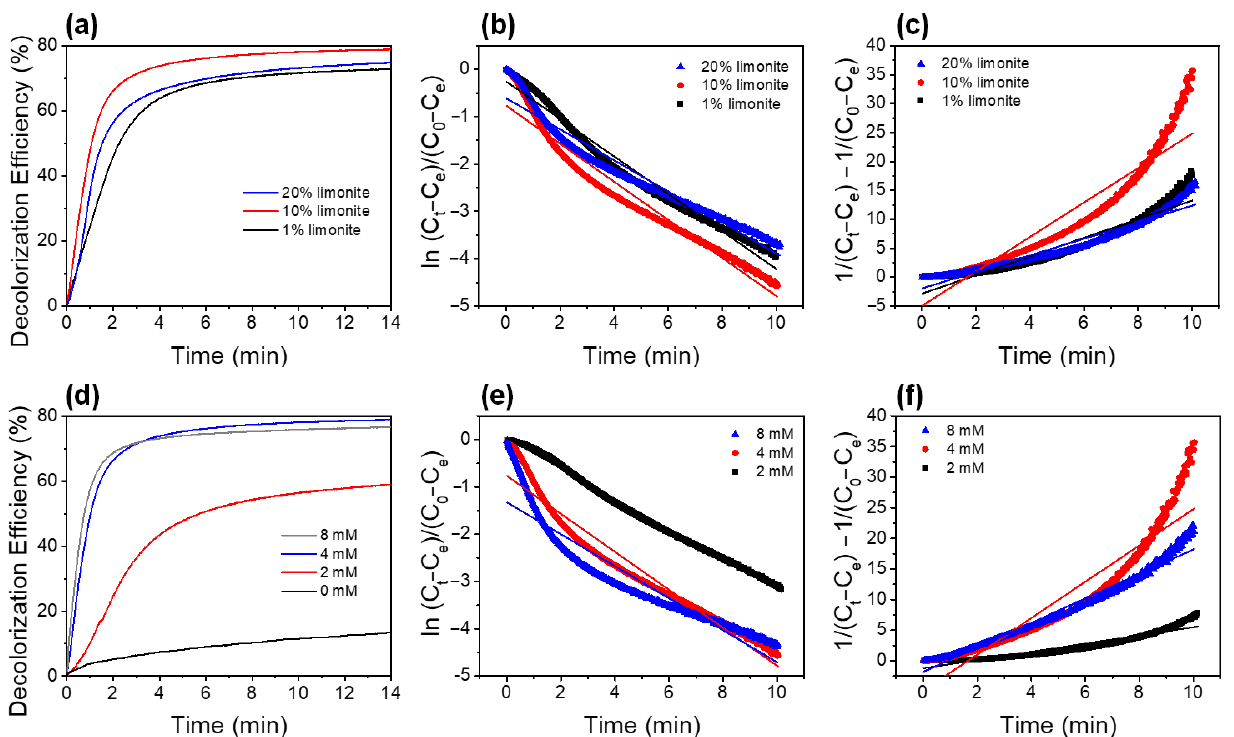
Figure 4. ( a ) Decolorization kinetics of MB with 4 mM PS using chitosan – limonite fibers (1%, 10%, and 20% limonite). Decolorization kinetics data fitted with ( b ) first- and ( c ) second-order reaction kinetic models. ( d ) Decolorization kinetics of MB using chitosan – limonite fibers (10% limonite) and different PS concentrations (2, 4, and 8 mM) on the MB decolorization with 10% limonite content. Decolorization kinetics data fitted with ( e ) first- and ( f ) second-order reaction kinetic models. Table 2. First- and second-order reaction kinetic model parameters for the decolorization of MB via SO 4 − · -based